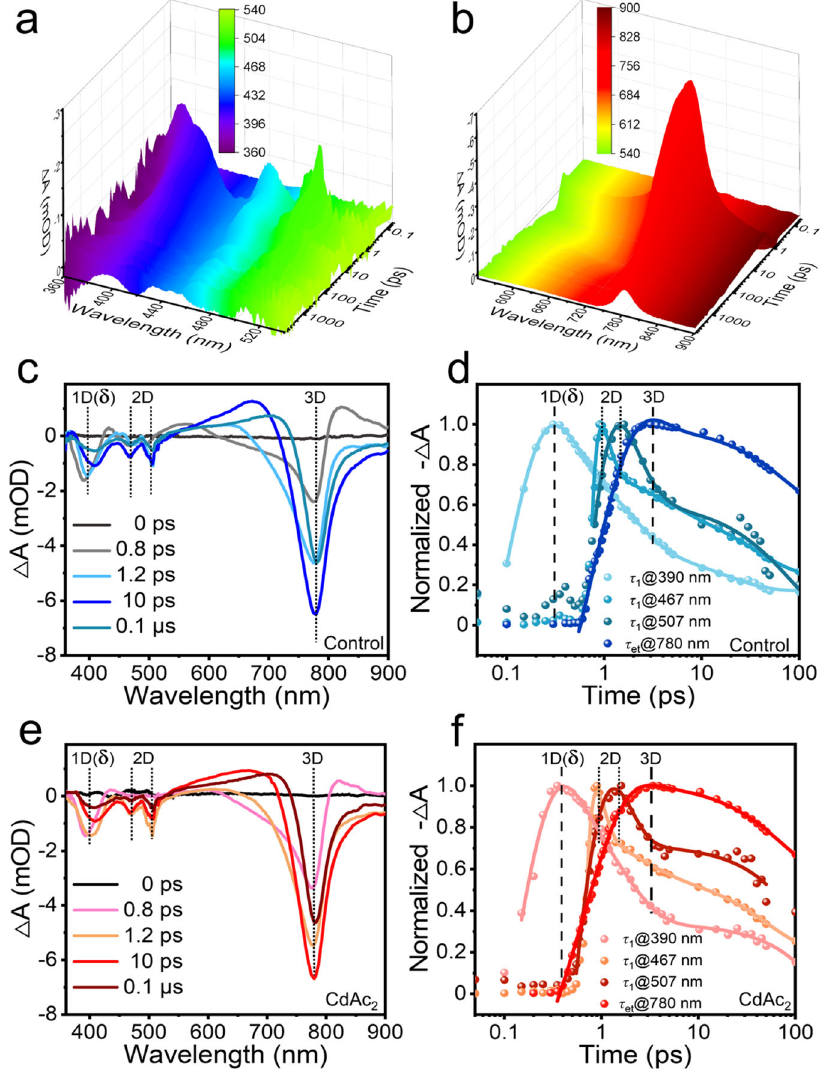
Fig. 3 | Energy transfer and recombination dynamics for perovskite fi lms and devices. TheoriginalTAspectralocated at a 360 – 540nmand b 540 – 900nmfora pristine FAPbI 3 perovskite fi lm. TA spectra at selected timescales of the FAPbI 3